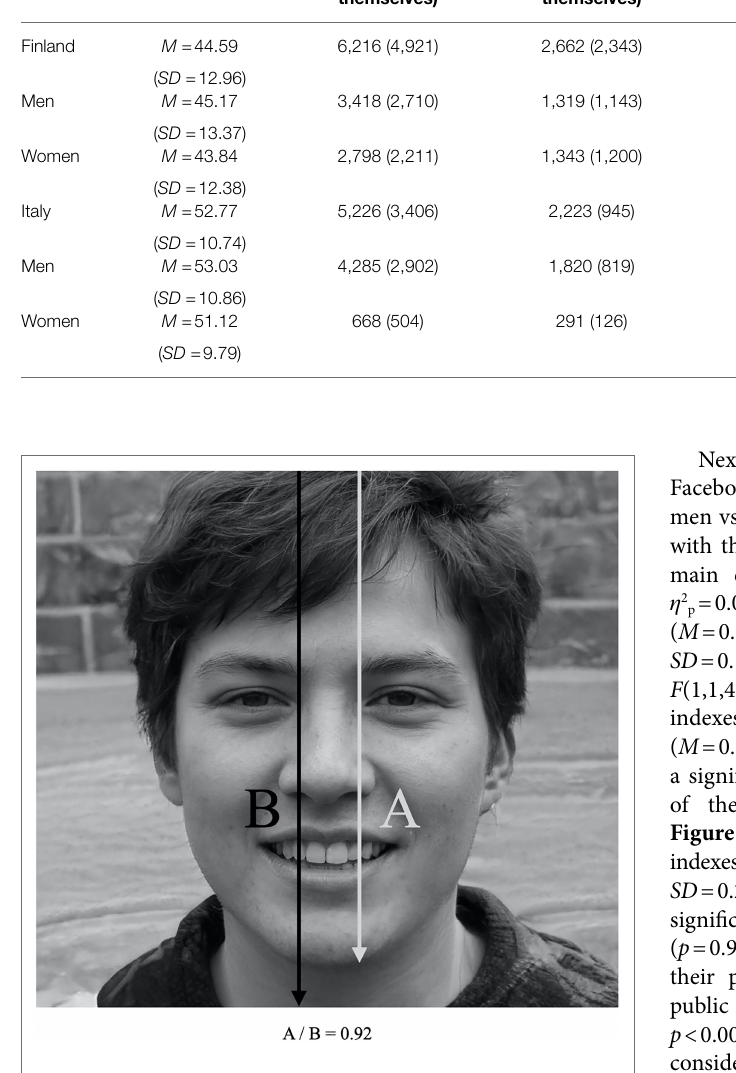
FIGURE 1 | Example of the two indexes calculated for each profile picture in order to compute the face-ism